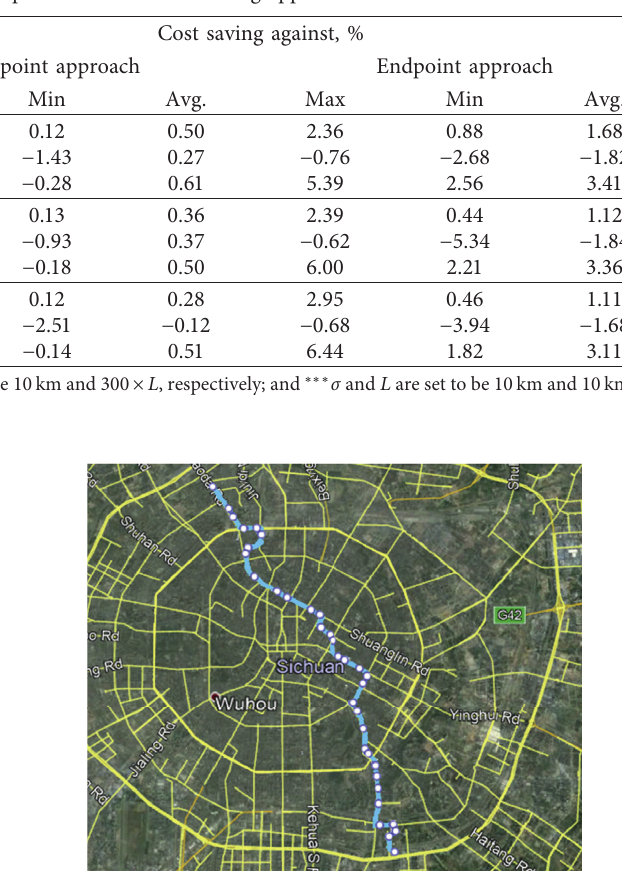
Table 3: Comparisons between the proposed method and existing approaches.